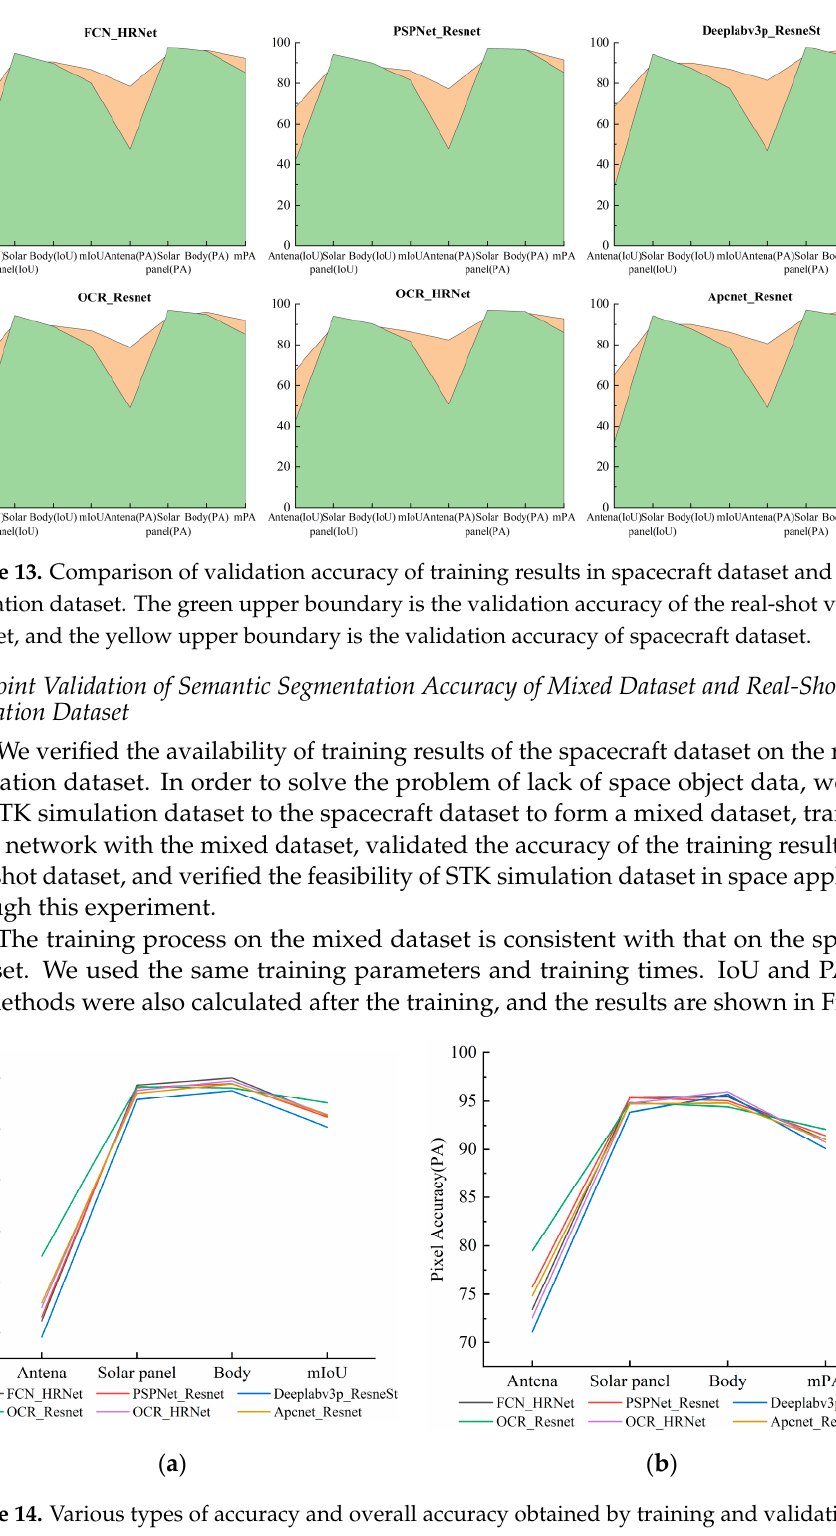
Figure 13. Comparison of validation accuracy of training results in spacecraft dataset and real-shot validation dataset. The green upper boundary is the validation accuracy of the real-shot validation dataset, and the yellow upper boundary is the validation accuracy of spacecraft dataset.